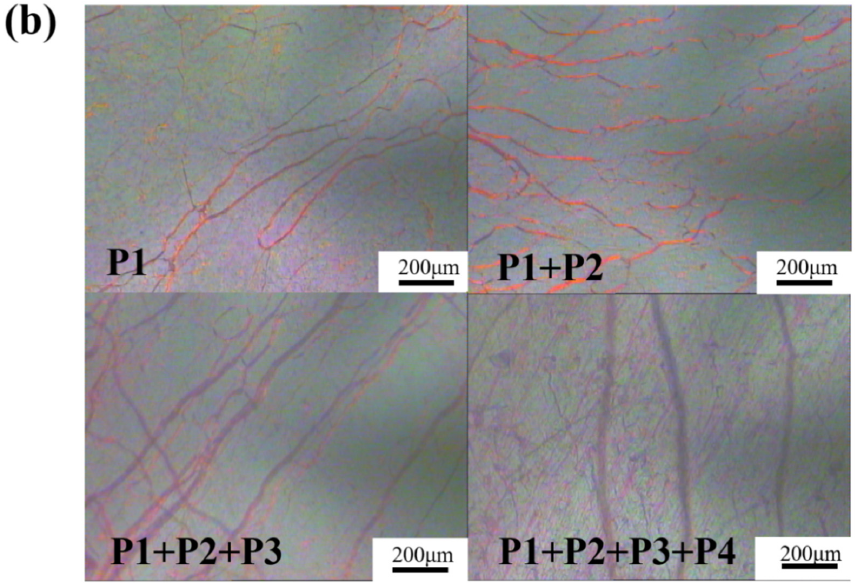
Figure 7. Transmission curves ( a ) and polarizing images ( b ) of multilayer PSCLC.